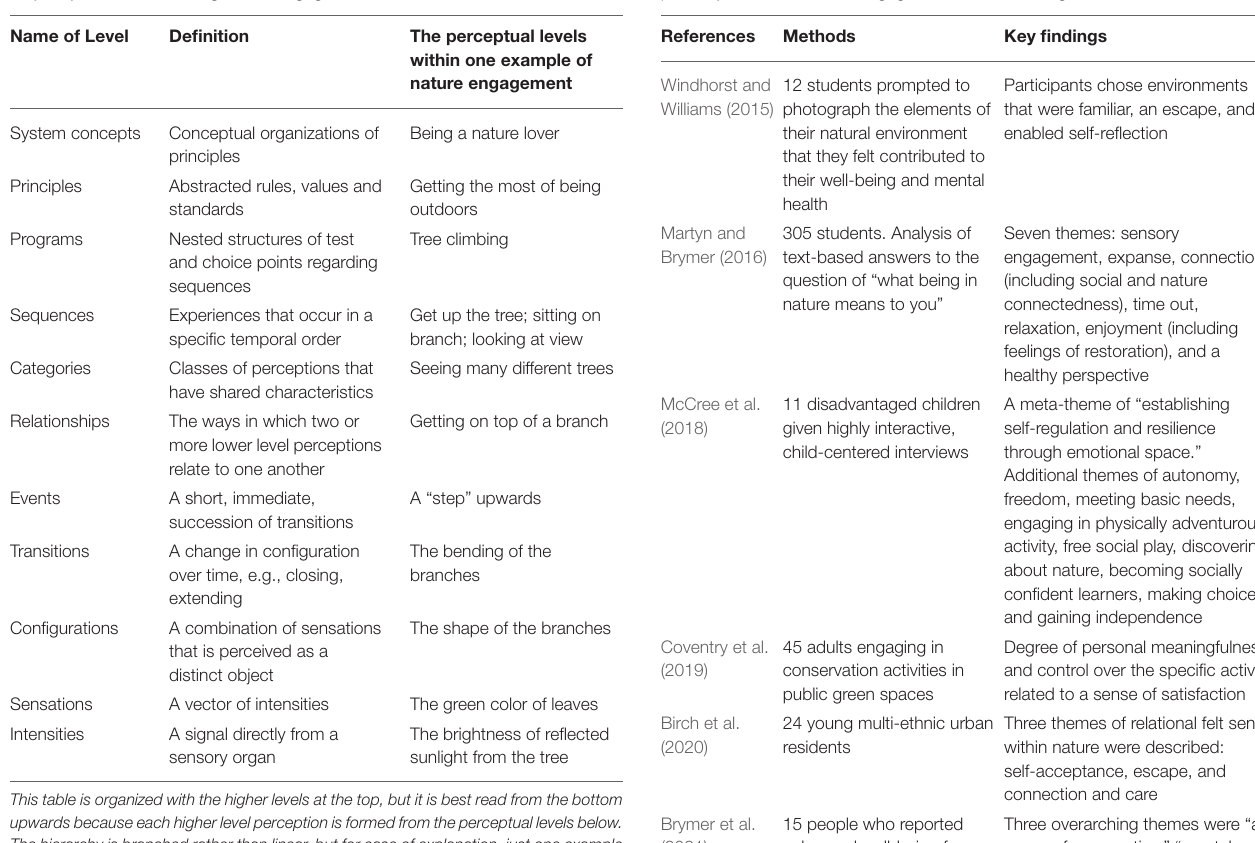
TABLE 2 | Examples of earlier qualitative studies and their findings regarding the pathways between nature engagement and